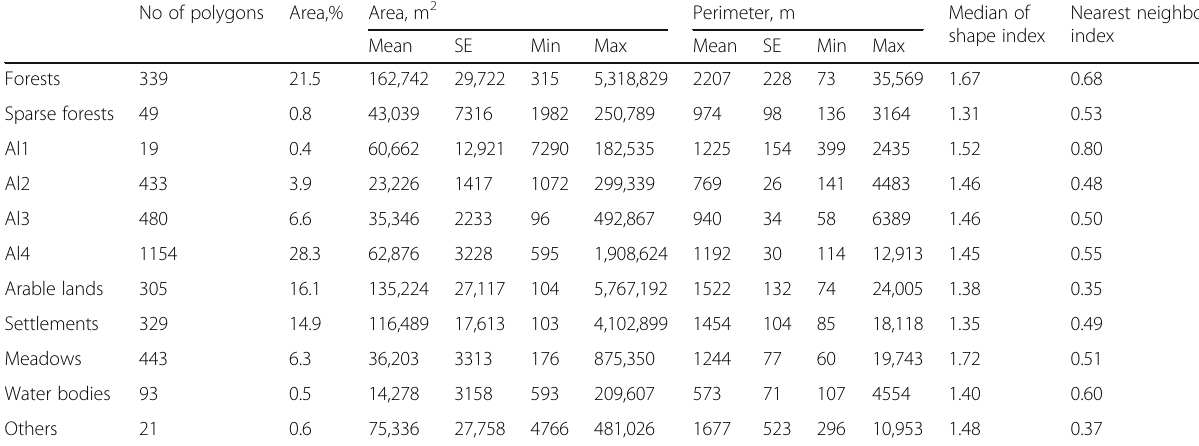
Table 1 Spatial parameters of the land type categories calculated taking account of their fire history No of polygons Area,% Area, m 2